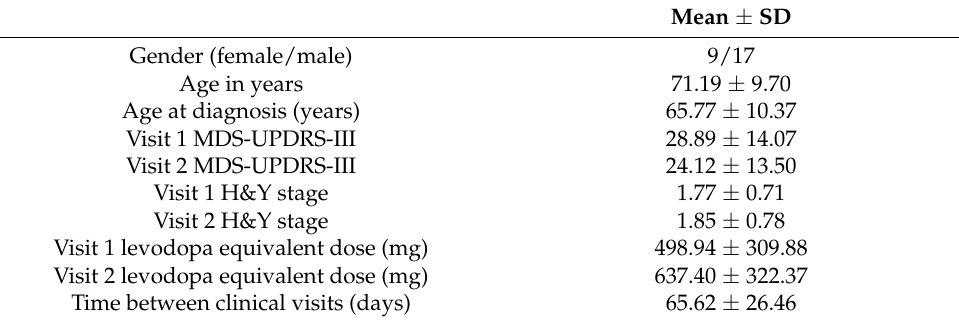
Table 1. Patient demographics and clinical